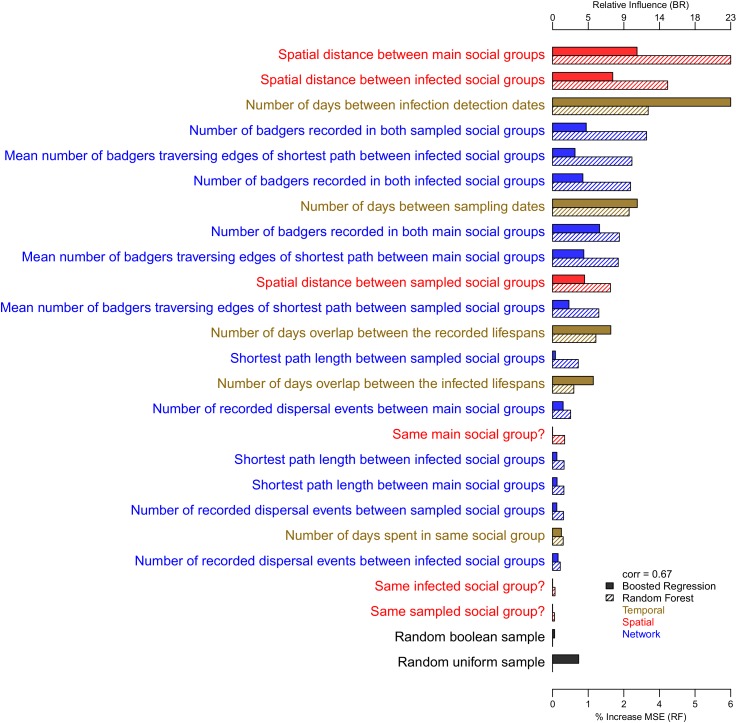
The importance of each epidemiological metric in explaining variation in the inter-badger-sequence genetic distance distribution.Metrics are coloured according to whether they used temporal (gold), spatial (red), or network (blue) information. The correlation (Pearson’s correlation) of the variable importance from the Random Forest and Boosted Regression models is reported in the legend. Two random metrics were included, a sample from a uniform distribution and a sample from a Boolean distribution, in the regression models.